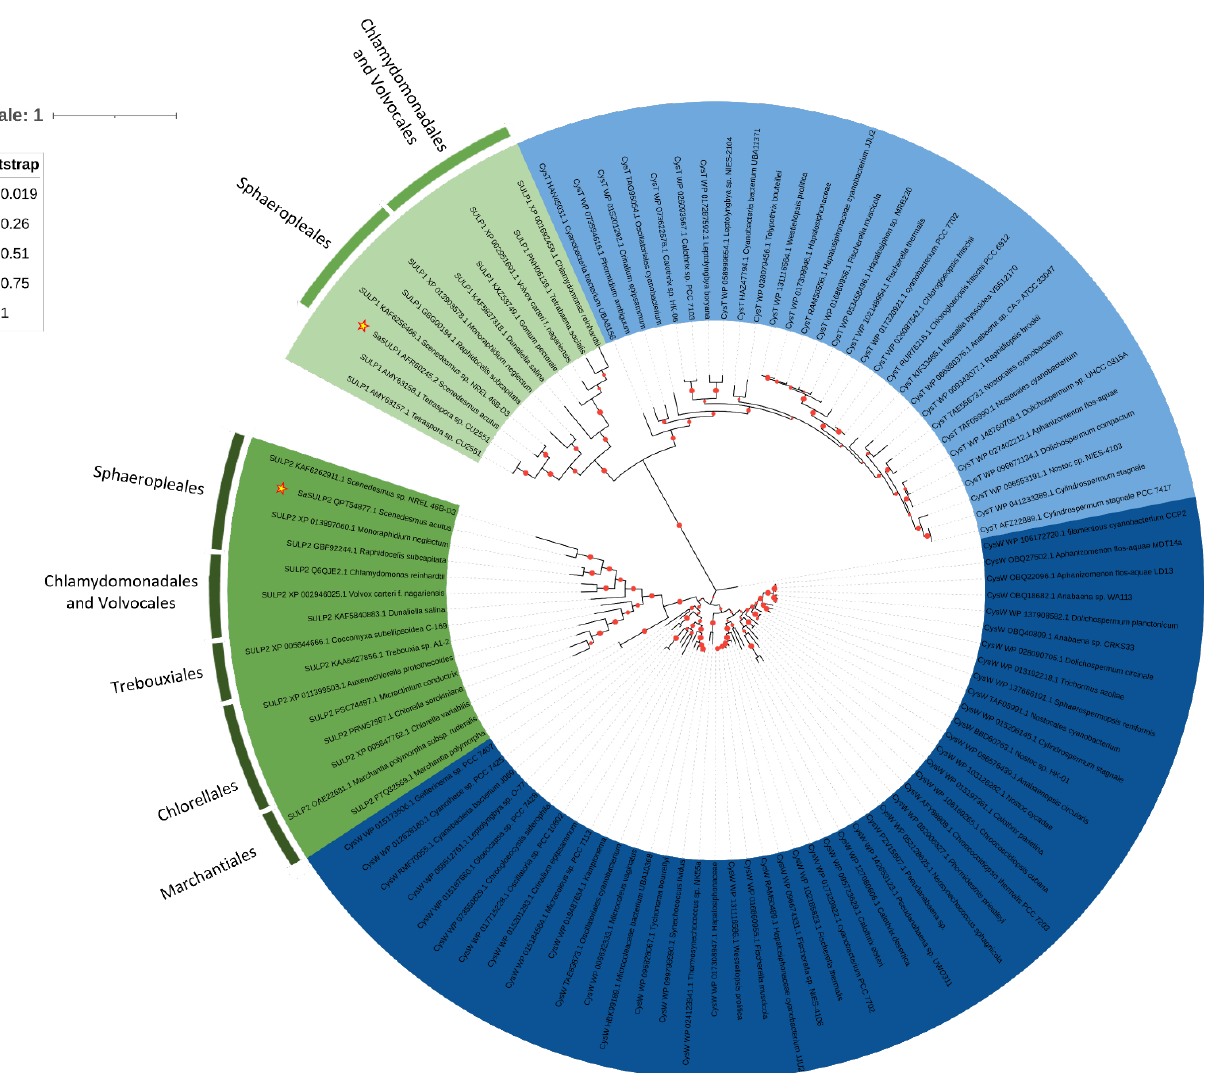
Figure 7. The evolutionary history of SULPs. The tree with the highest log likelihood (−25 ,726.73) is shown. The percentage of trees in which the associated taxa clustered together is shown below the branches. The tree is drawn to scale, with branch lengths measured in the number of substitutions per site. This analysis involved 103 amino acid sequences (Table S1) for a total of 1036 positions in the final dataset.